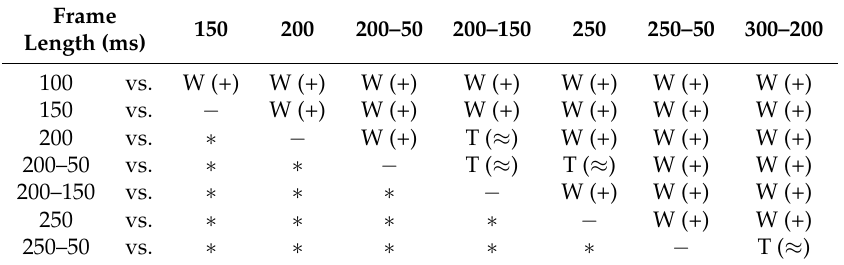
Table 2. Comparison of mean classification performance for different frame lengths (row values